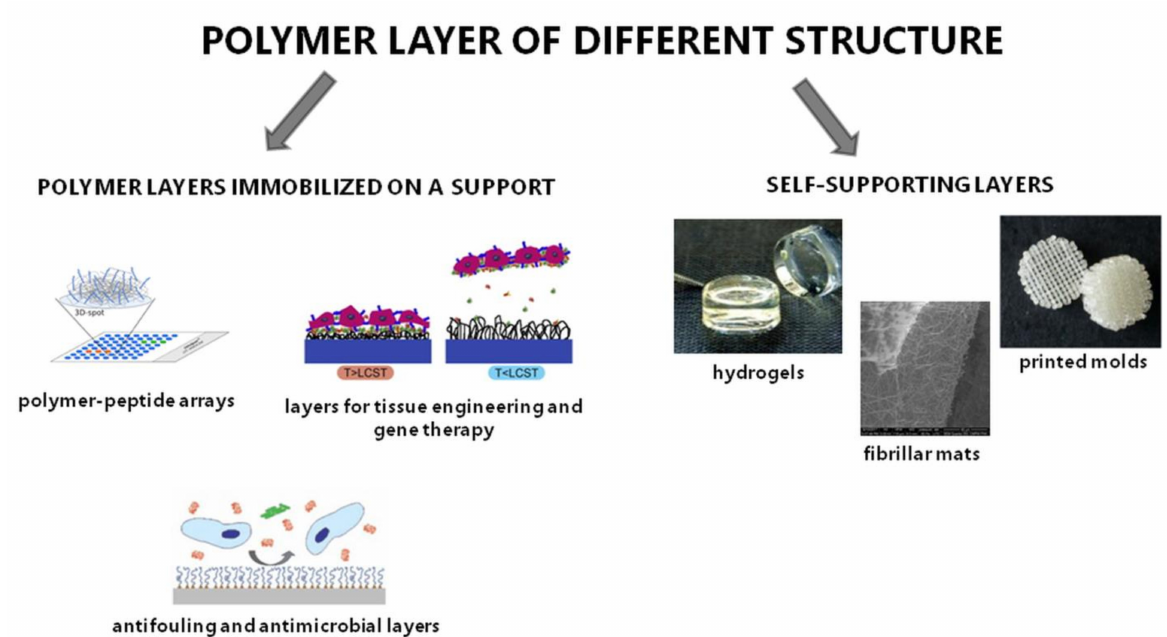
Figure 7. Schematic representation of the polymer layers obtained in the Laboratory of Micro- and Nanomaterials of CMPW PAS.